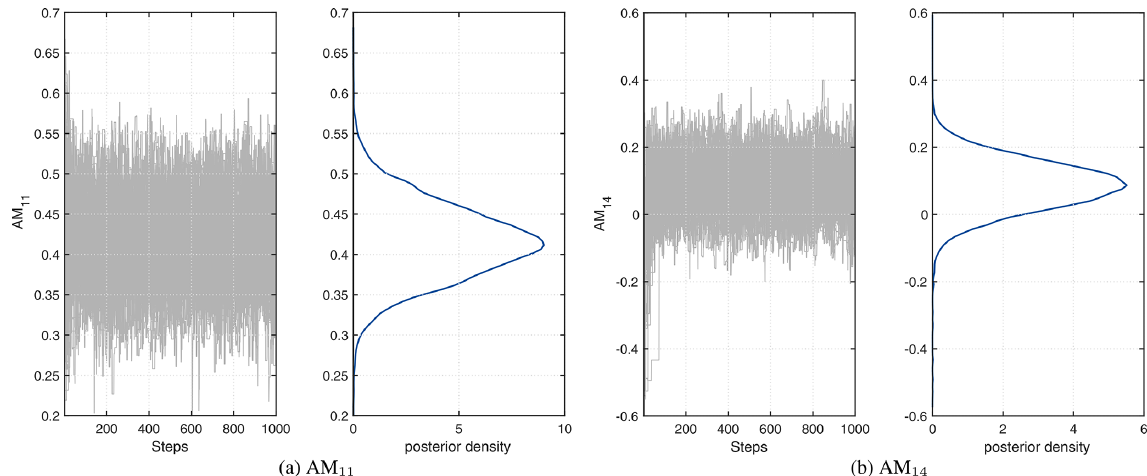
Figure C2. Examples of MCMC chains and resulting posterior for parameters AM 11 and AM 14 . For the results reported in Sect. 5.2, the first 50% of the chains is discarded (so-called